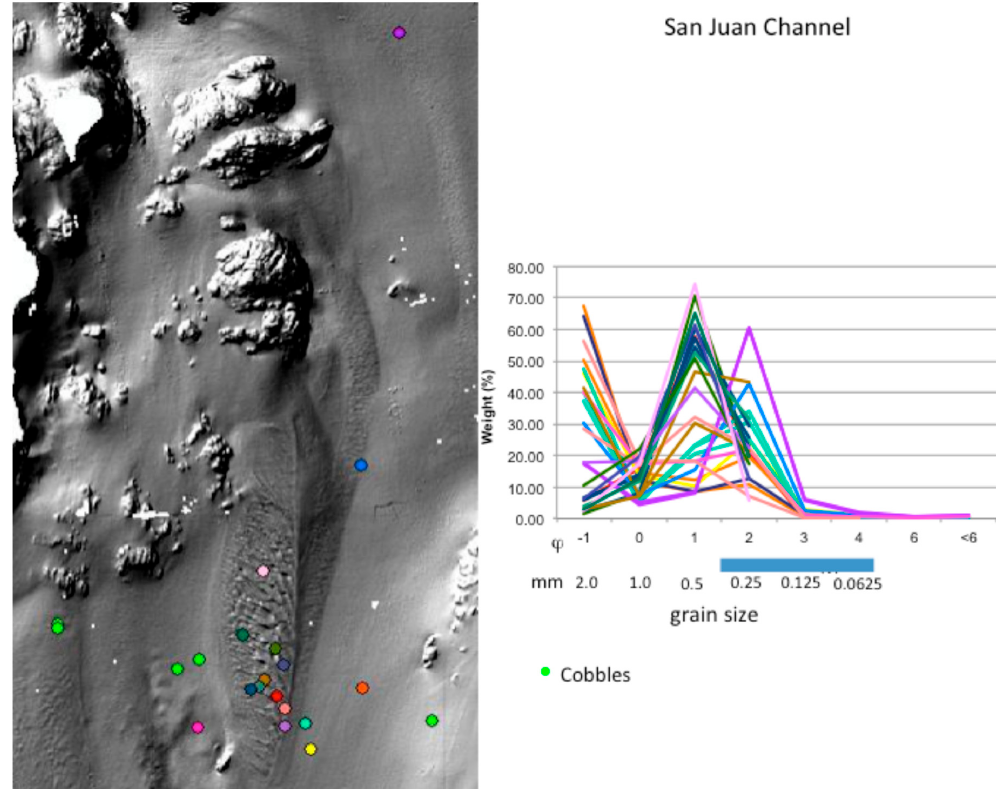
Figure 8. Sediment samples [22] collected and analyzed for this study; (on left, MBES image) location of samples; color dots represent sample sites, and (right) graph of grain sizes from sieve analyses showing grain size distribution.